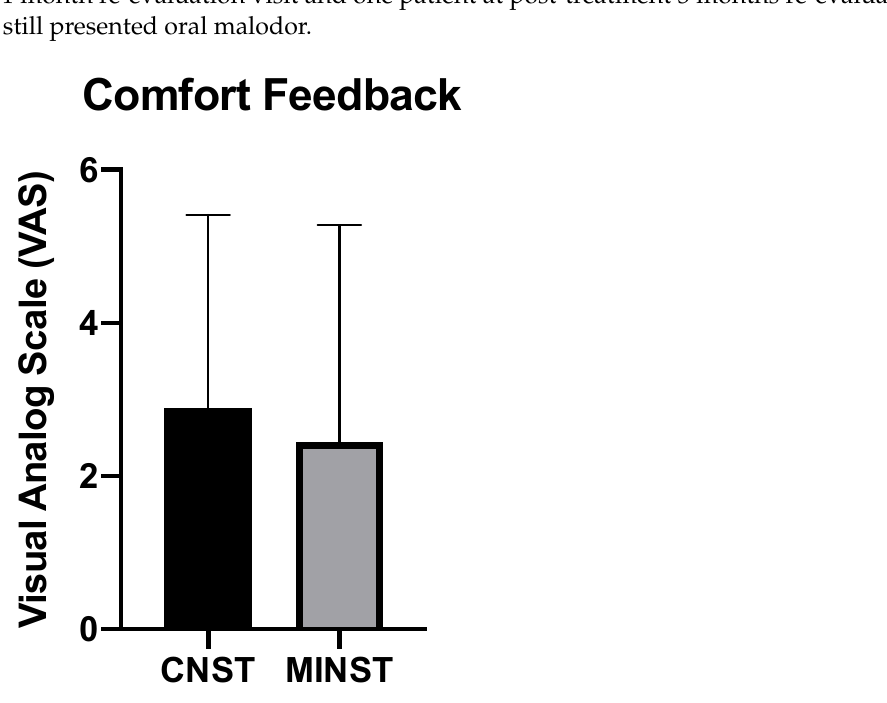
Figure 3. Patients’ comfort feedback. Analyzed by Mann–Whitney U test. Statistical significance set as p value < 0.05.